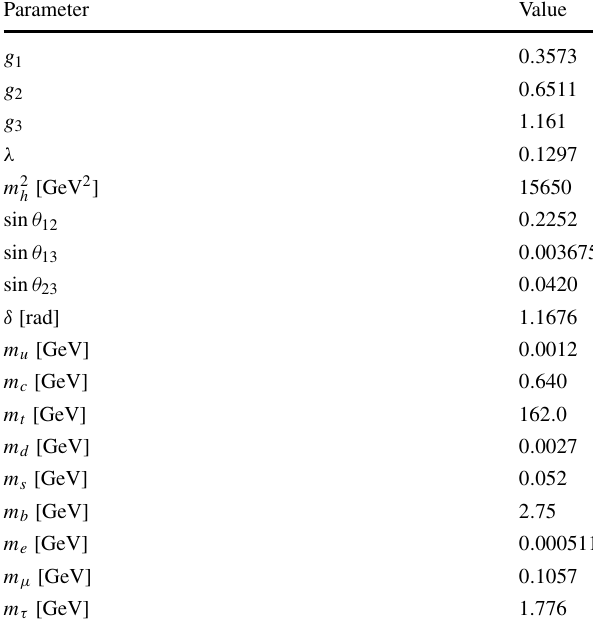
Table 4 SM parameters used by default to generate SM initial condi- tions at an arbitrary scale. The scale at which these parameters are given is μ = 173 . 6 GeV. We follow UTfit for what concerns the conventions for the CKM matrix